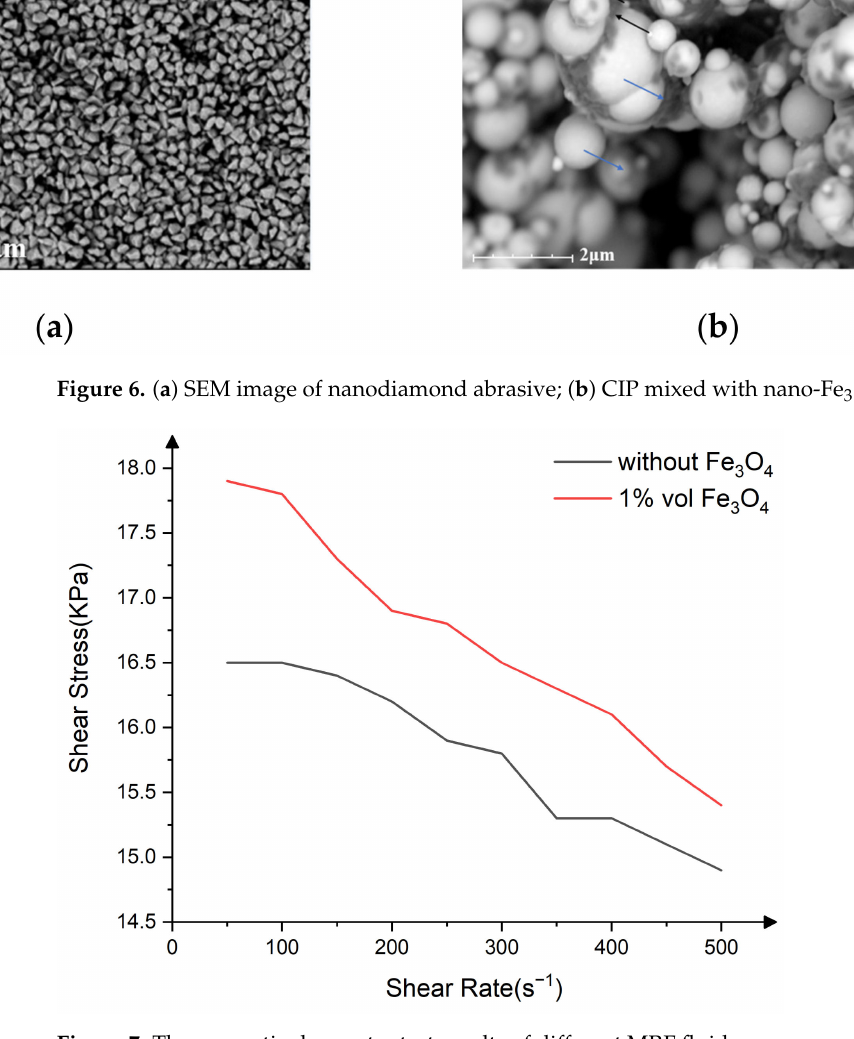
Figure 7. The magnetic rheometer test results of different MRF fluid. From Figure 9a, it can be seen that each sample has strong peaks at the position of 471 cm − 1 (Si-O), 778 cm − 1 (Si-O), and 1113 cm − 1 (Si-O-Si) [42], which are the characteristic peaks of SiO 2 , and the absorption peaks of Samples No. 2 and No. 3 are significantly stronger than that of Sample No. 1. In addition, compared with Sample No. 1 and No. 2, Sample No. 3 has a strong absorption band at 973 cm − 1 (Si-OH). It can be seen from Figure 9b, at the position of 3417 cm − 1 (OH group), the absorption bands of Sample No. 1, Sample No. 2, and Sample No. 3 are intensified sequentially